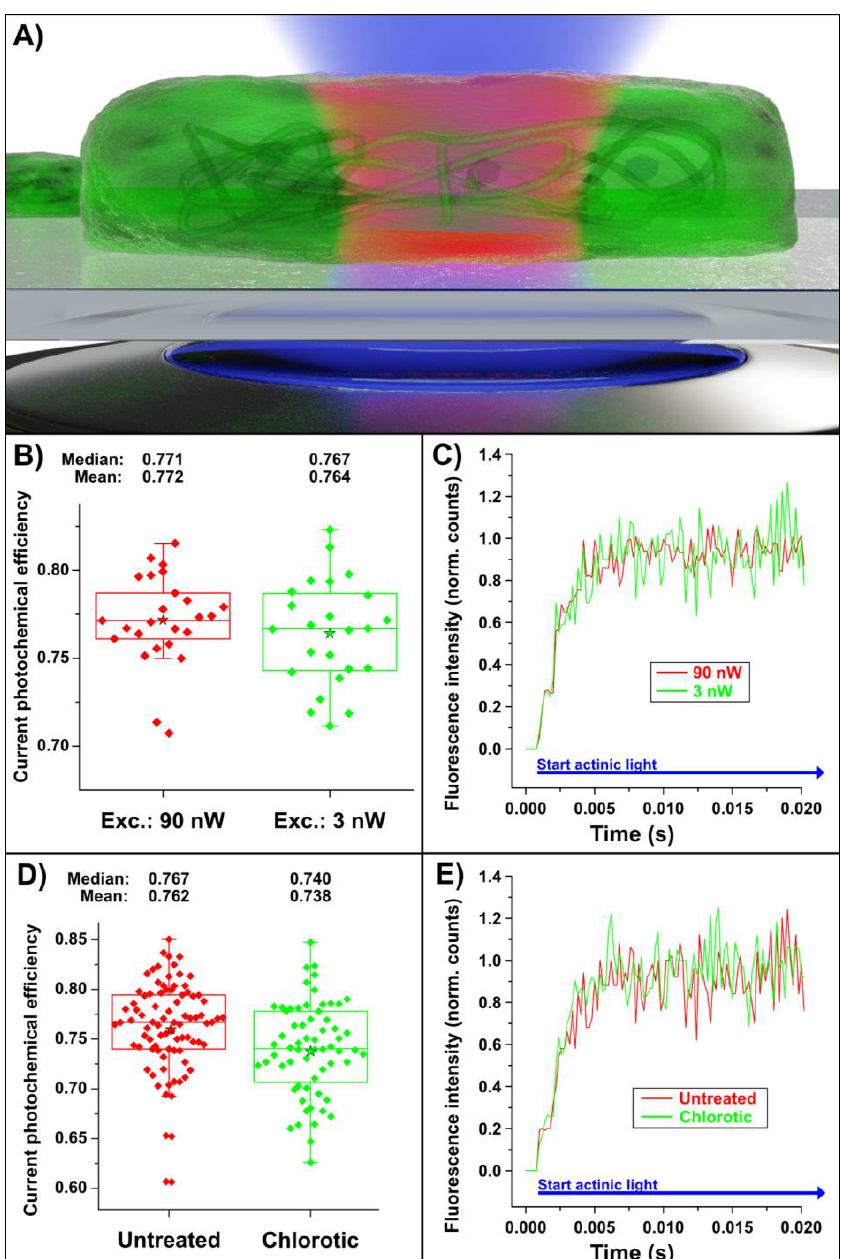
Figure 2. ( A ) Schematic illustration of a single bacterium on a glass coverslip in the focal volume of a high-numerical-aperture (NA = 1.4) objective lens. ( B ) Box plot of the quantum yield of S. elongatus irradiated by 90 nW (red dots) and 3 nW (green dots) laser power to prove the independence of the photosynthetic efficiency from the laser power. There is no significant difference between 90 and 3 nW (two-tailed t -test, p = 0.343). ( C ) Two representative fluorescence curves recorded with a laser excitation intensity of 90 nW (red curve) or 3 nW (green curve). The curves were normalized to F M because different amounts of chlorophyll were measured due to different bacterial sizes, allowing a direct comparison. ( D ) Box plot of the effective quantum yield of S. elongatus in free space (red curve) and chlorotic cells (nitrogen starved) in free space (green curve). Statistically, the median of the quantum yields of the free space and the chlorotic bacteria differ significantly (two-tailed t -test p = 3.10 × 10 − 3 ). ( E ) Two representative fluorescence curves (normalized to F M ) of untreated cyanobacteria (red curve) and cyanobacteria grown under chlorotic conditions (green curve). The star in ( B ) and ( D ) represents the